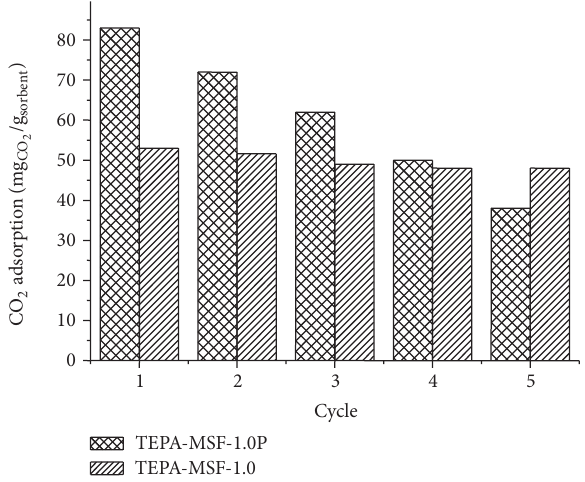
F 6: Cyclic runs of